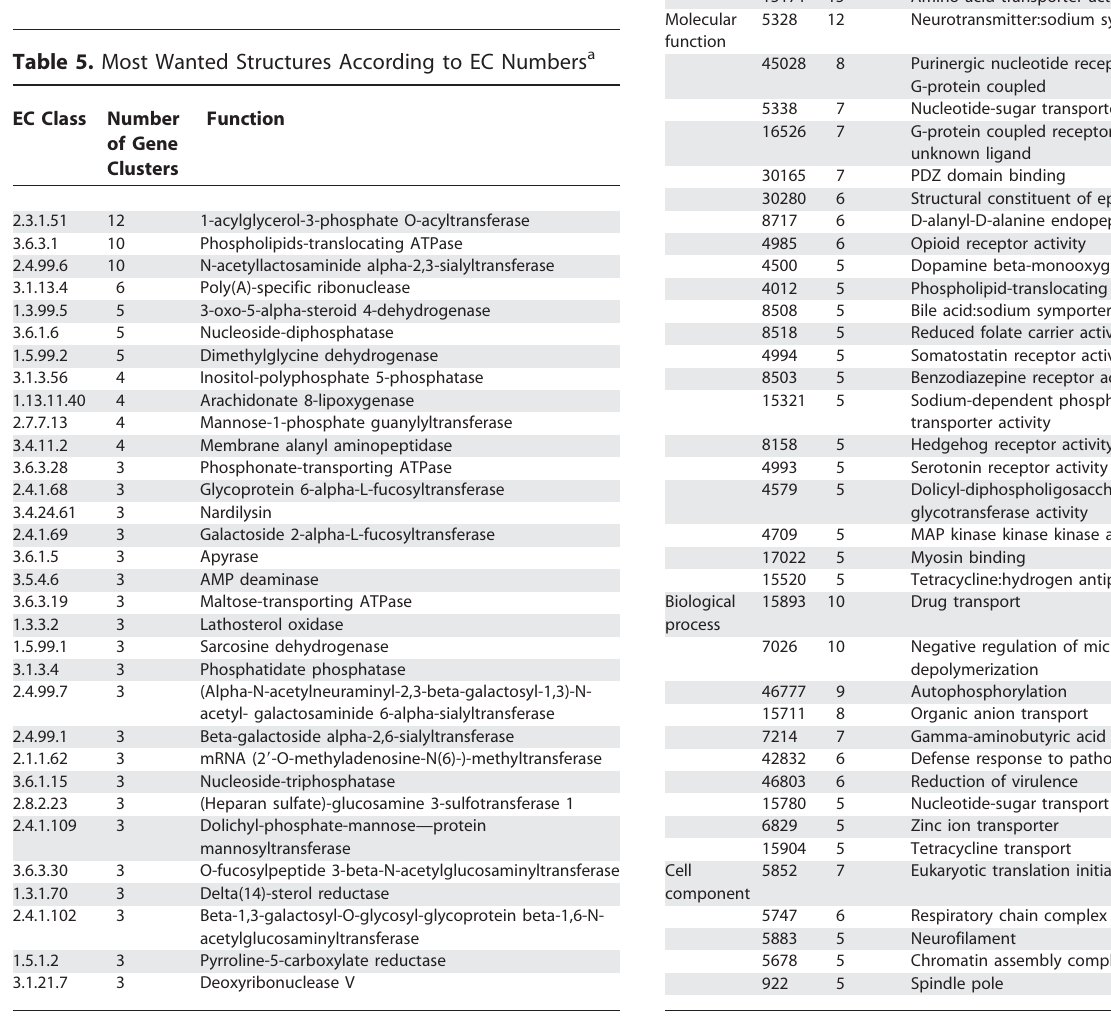
Table 5. Most Wanted Structures According to EC Numbers a